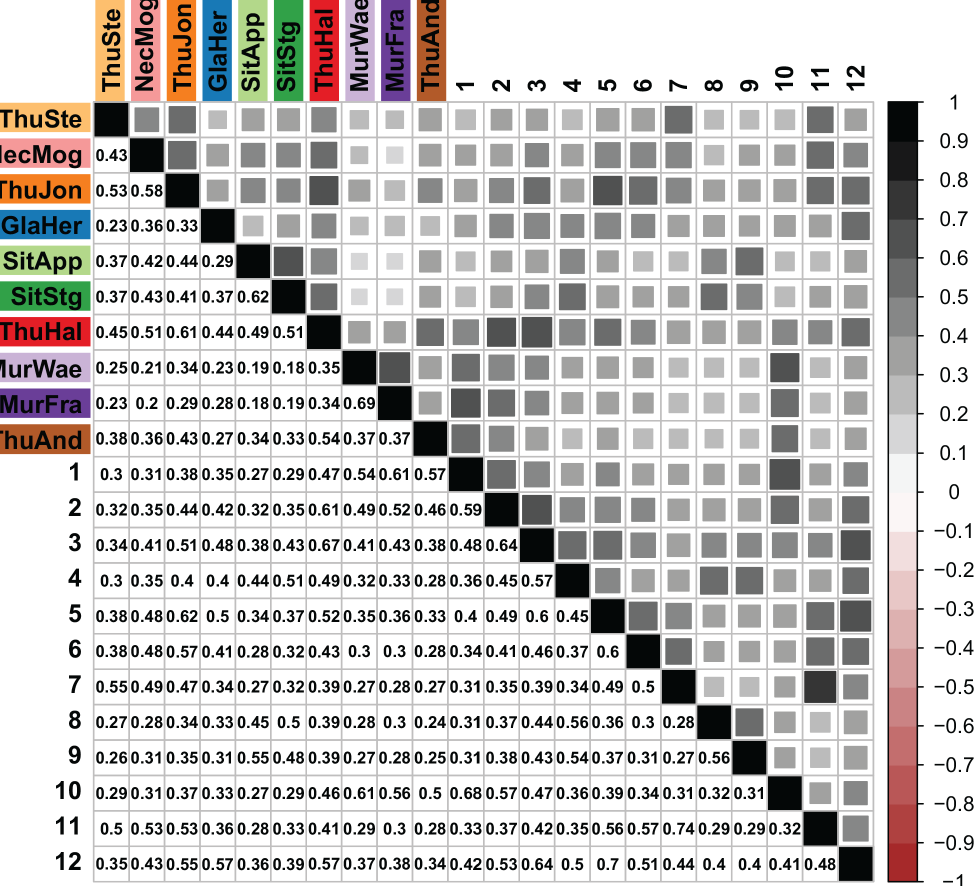
Figure 11. Kendall’s tau matrix of samples generated by the Fisher copula for the 10 gauged (colored abbreviations) and 12 ungauged (numbers 1–12) locations (see Fig. 1). Kendall’s tau matrix of the samples generated does not equal the matrix displayed in Fig. 8 for the Fisher copula since the samples are randomly generated and therefore not perfectly